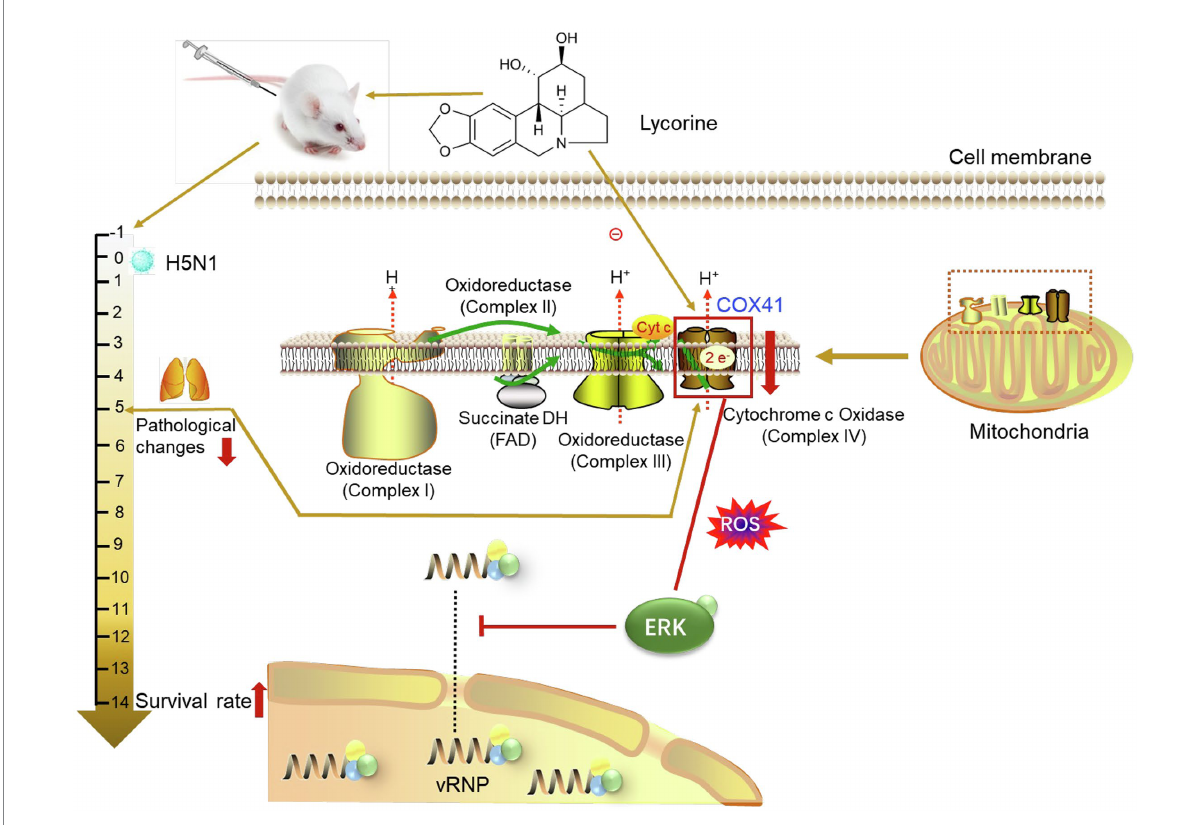
FIGURE 6 Protective effects of lycorine on H5N1 infection in vivo and in vitro . COX41 activates the ERK signaling and promotes the nuclear export of vRNP. Lycorine inhibits the nuclear export of vRNP and viral replication through suppressing the expression of